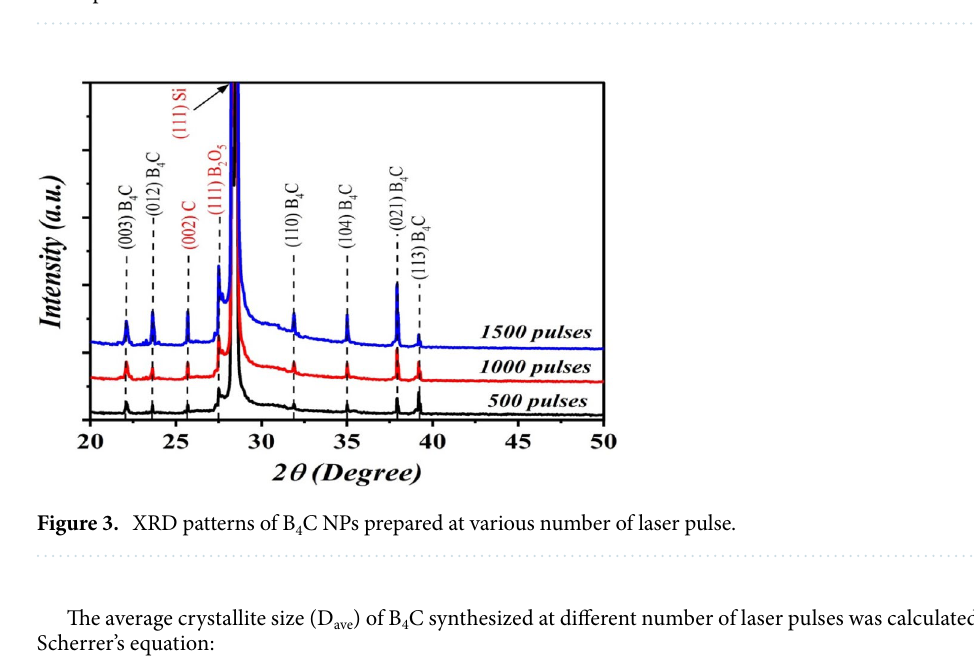
Figure 2. ( a ) Schematic illustration of B 4 C /p-Si heterojunction photodetector and ( b ) optical image of top view of the photodetector with dimensions.